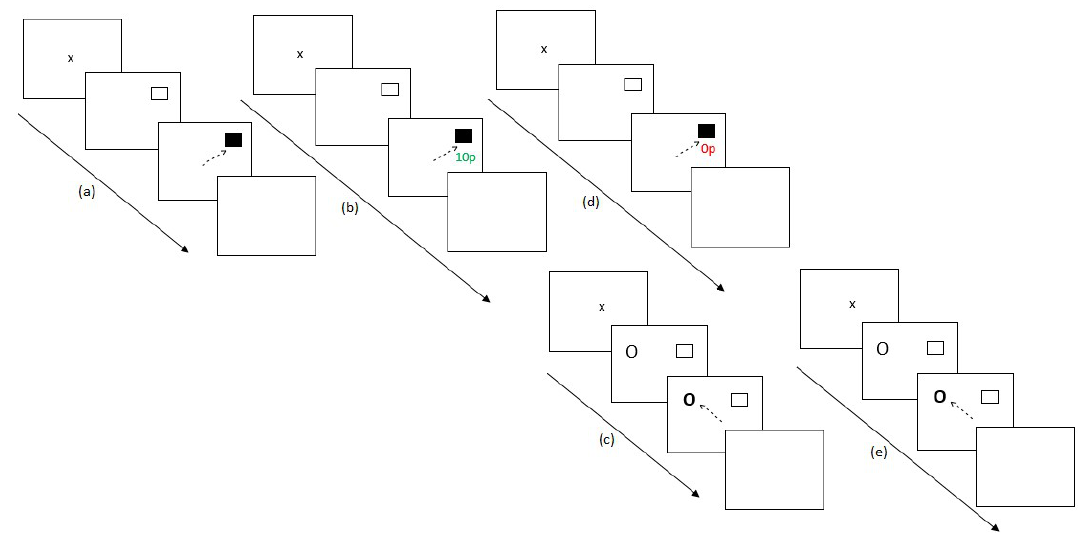
Figure 1. Experimental procedure for Experiment 1. ( a ) After assessing for eye dominance and a 9-point calibration procedure, participants completed 2 baseline blocks of the reward paradigm where no reward feedback was displayed. ( b ) Participants then completed 10 conditioning blocks of the reward paradigm where only one hemifield was rewarded at a 60% schedule. ( c ) Participants then switched tasks, completing six blocks of the remote distractor task to assess whether reward had any e ff ect on this secondary unrewarded task. ( d ) A further six blocks of the reward paradigm were completed where no reward was given to participants for saccades. ( e ) Participants completed a final six blocks of the remote distractor task and the experiment ended.